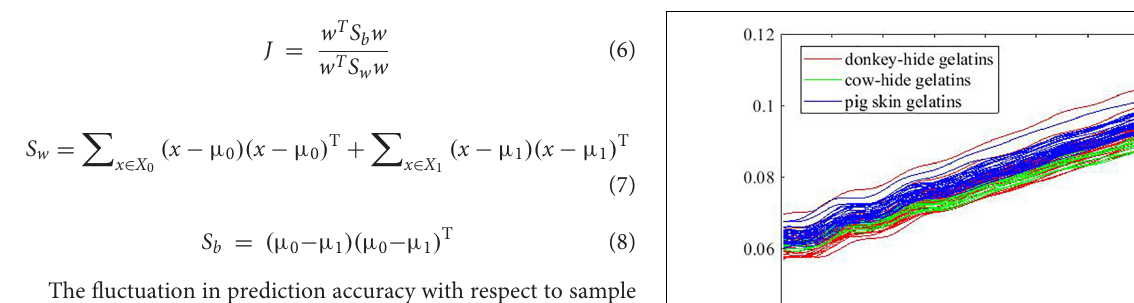
FIGURE 7 | Extinction coefficient of samples in Part A.